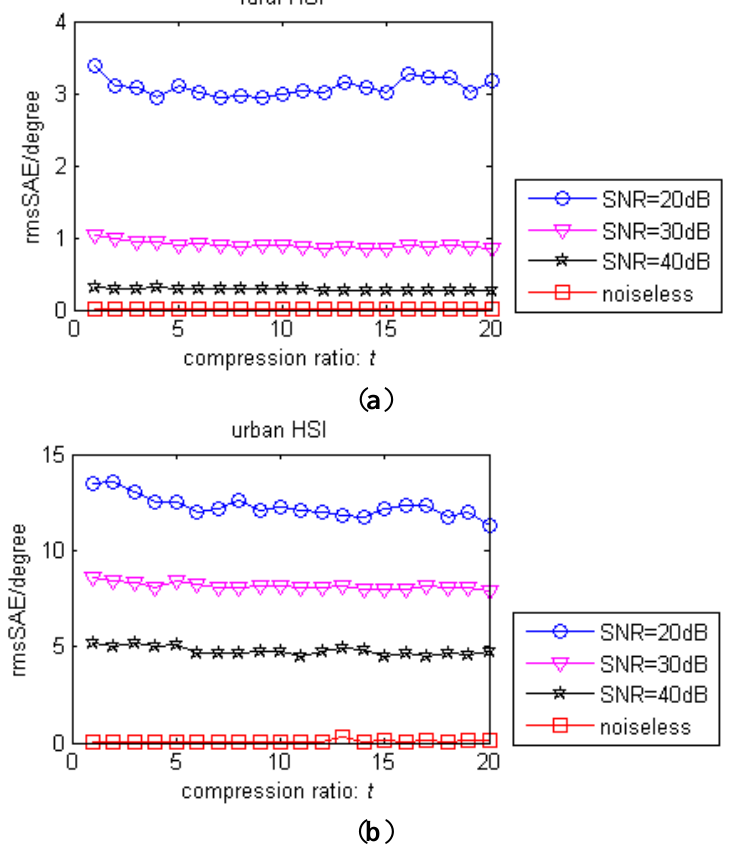
Figure 9. ( a ) Rural HSI: the rmsSAE of the proposed method as a function of the compression ratio t with different SNR; ( b ) Urban HSI: the rmsSAE of the proposed method as a function of the compression ratio t with different SNR.